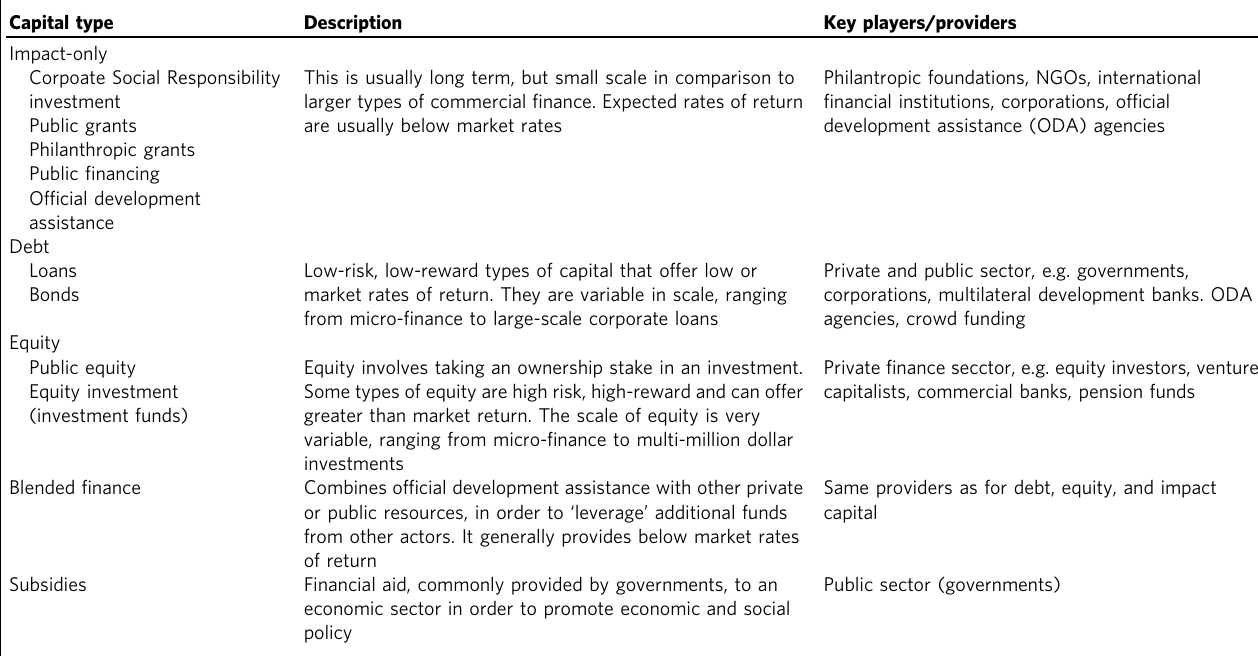
Table 1 Summary of major capital types and key providers of these capital 3 .